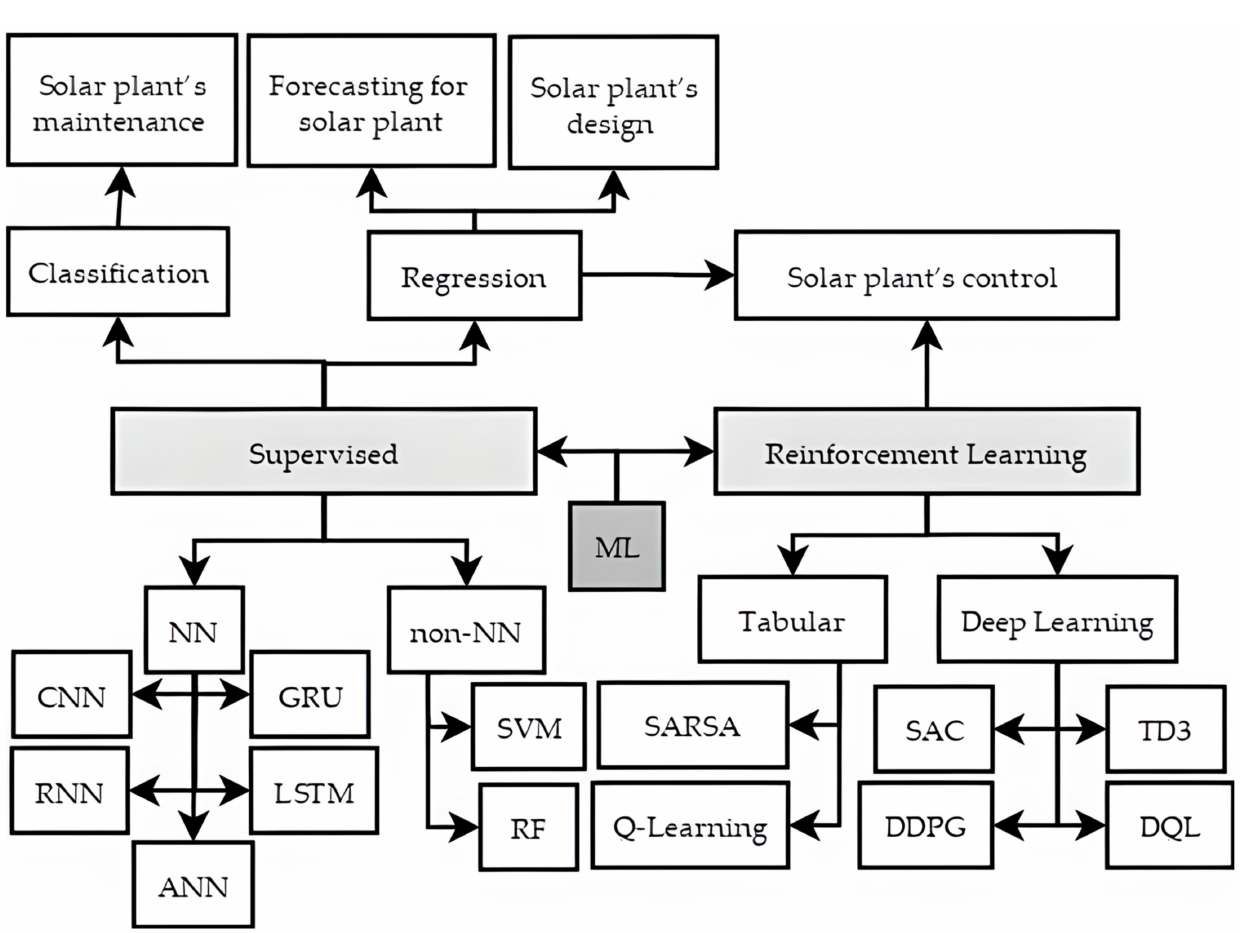
Figure 2. Classification of tasks that are solved based on ML